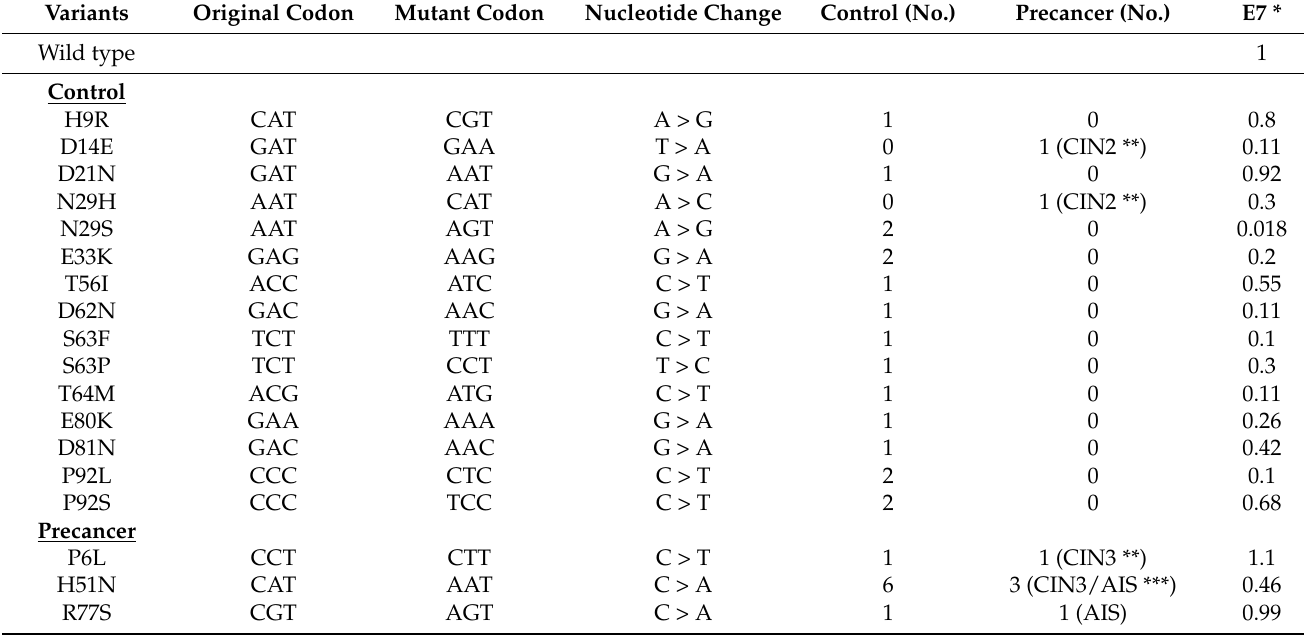
Table 1. HPV16 E7 variants tested and associated nuclear protein levels of